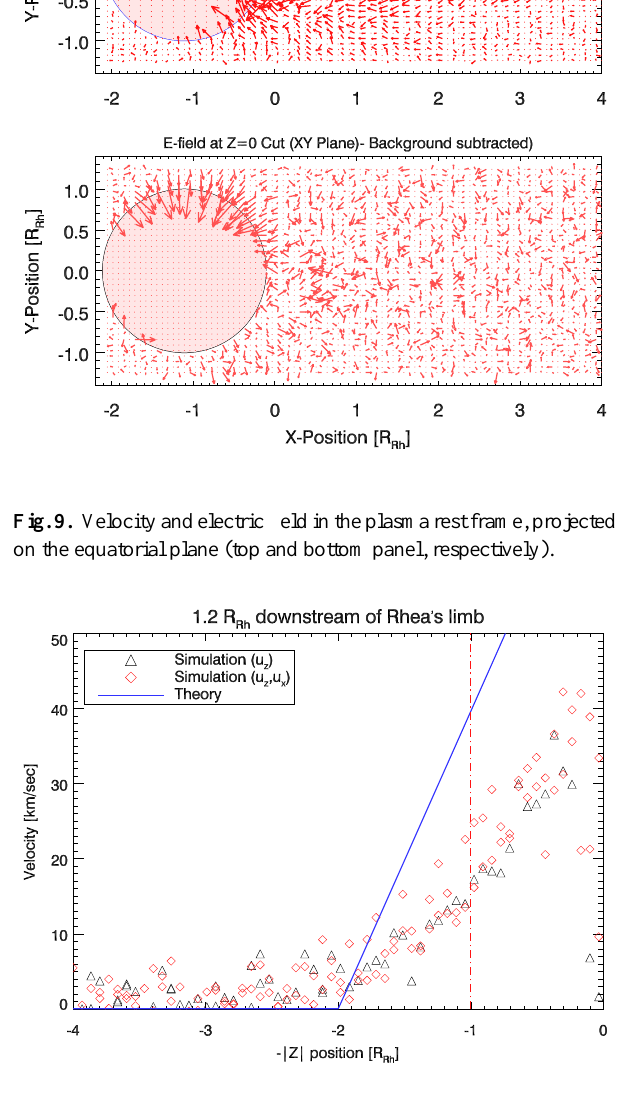
Fig. 10. Comparison of Equation 10 solution (blue line) with the simulated data, for a distance of 1.2 R Rh downstream of Rhea’s limb. Triangles show the variation of v z from our simulation results, while diamonds show the velocity variation when the residual v x is considered.